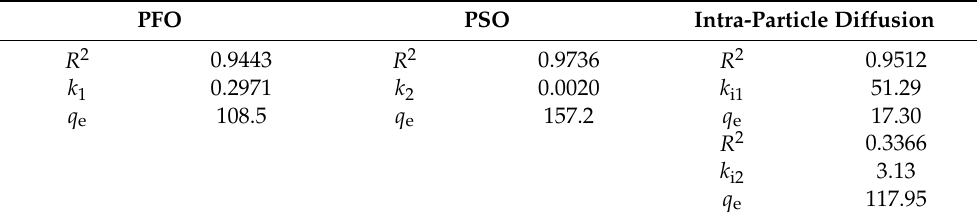
Table 1. Adsorption kinetic